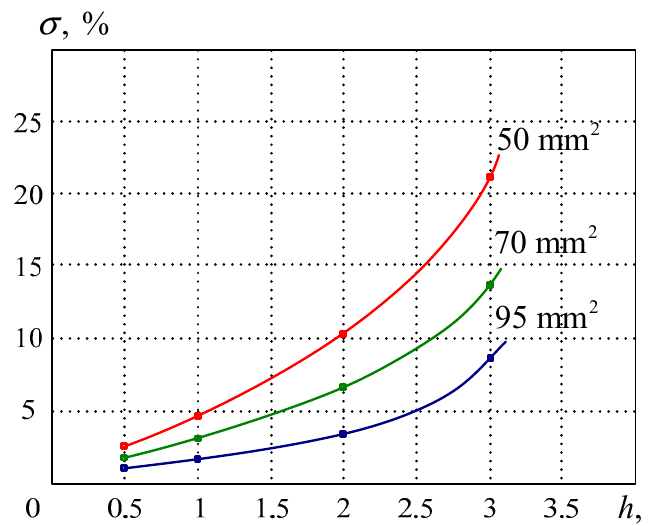
Figure 7. Distribution of relative depth detection error. Relative depth detection error peaked at 23% on average at 3 m for the cable whose main conductors (copper) had ; minimum error of 2% was observed for 2 95 mm S = copper conductors.